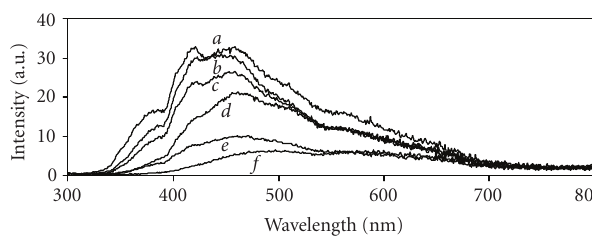
Figure 5: Synchronous fluorescence spectrum ( Δ λ = 20 nm) of Colombian petroleum. Irradiation times: (a) 0h, (b) 5 h, (c) 15 h, (d) 20 h, (e) 60 h, and (f) 100 h. Table 2: Fluorescence percentage of the oils calculated through the integrated area of the spectra corresponding to the irradiated sam- ples. Integrated area of fluorescence Irradiation time Arabian oil Nonirradiated 100%